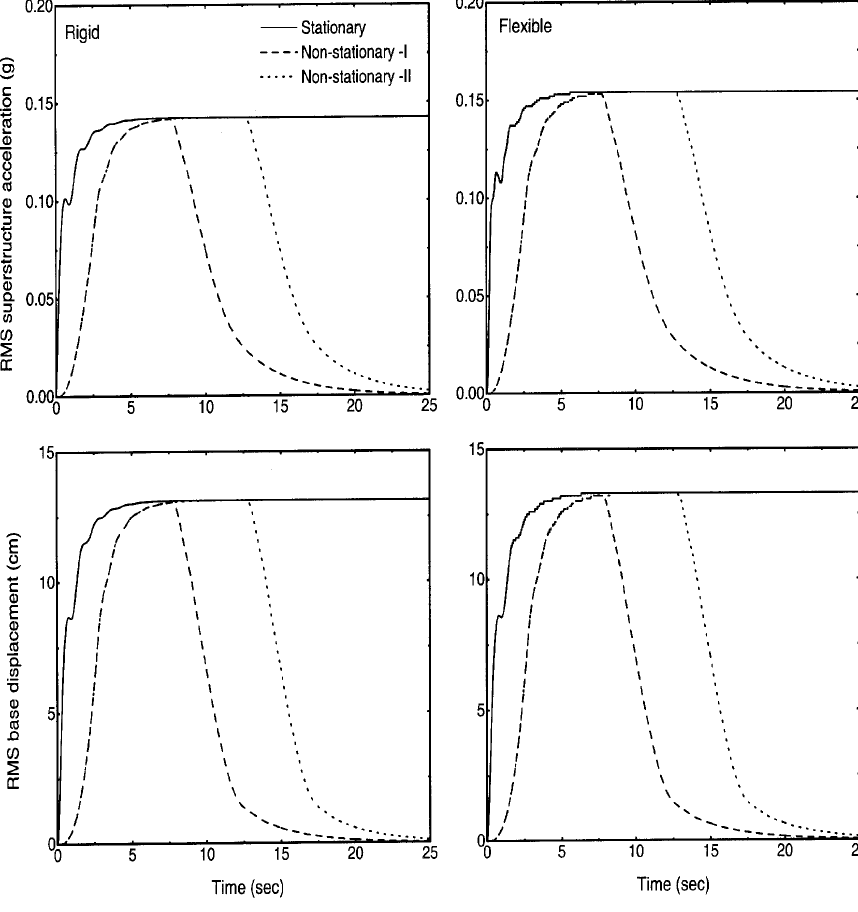
Fig. 5. Time variation of the RMS superstructure acceleration and base displacement of the structure isolated by the N-Z system ( T s = 0 . 5 sec, T = 2 . 5 sec, ξ = 0 . 1 and F 0 = 0 . 05 b b